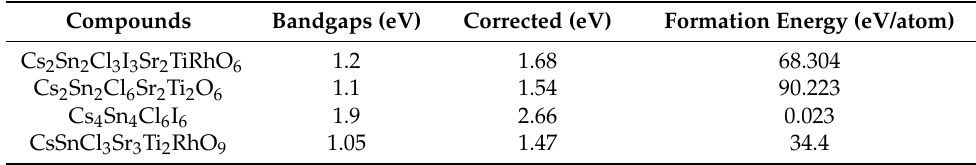
Table 4. Electronic bandgap for 2 × 2 × 1 mixed perovskites as well as formation energy.